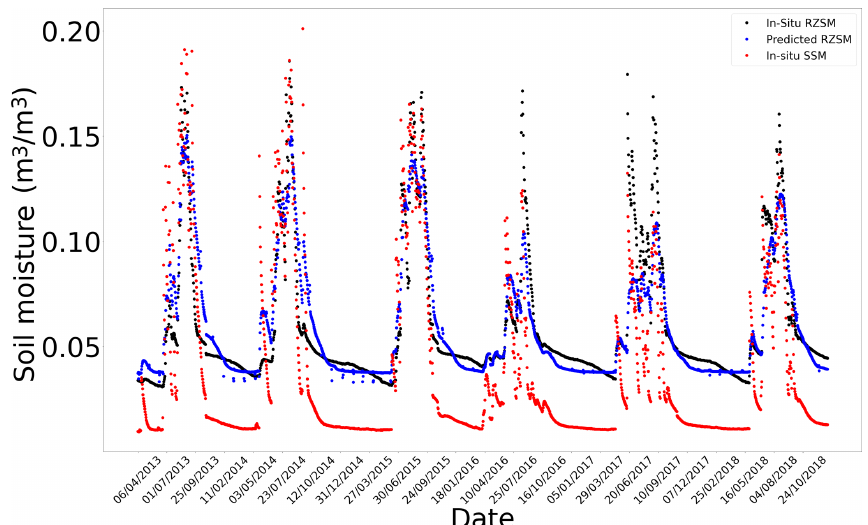
Figure E10. In situ SSM, in situ RZSM, and predicted RZSM series at station Wankama (AMMA-CATCH) with model